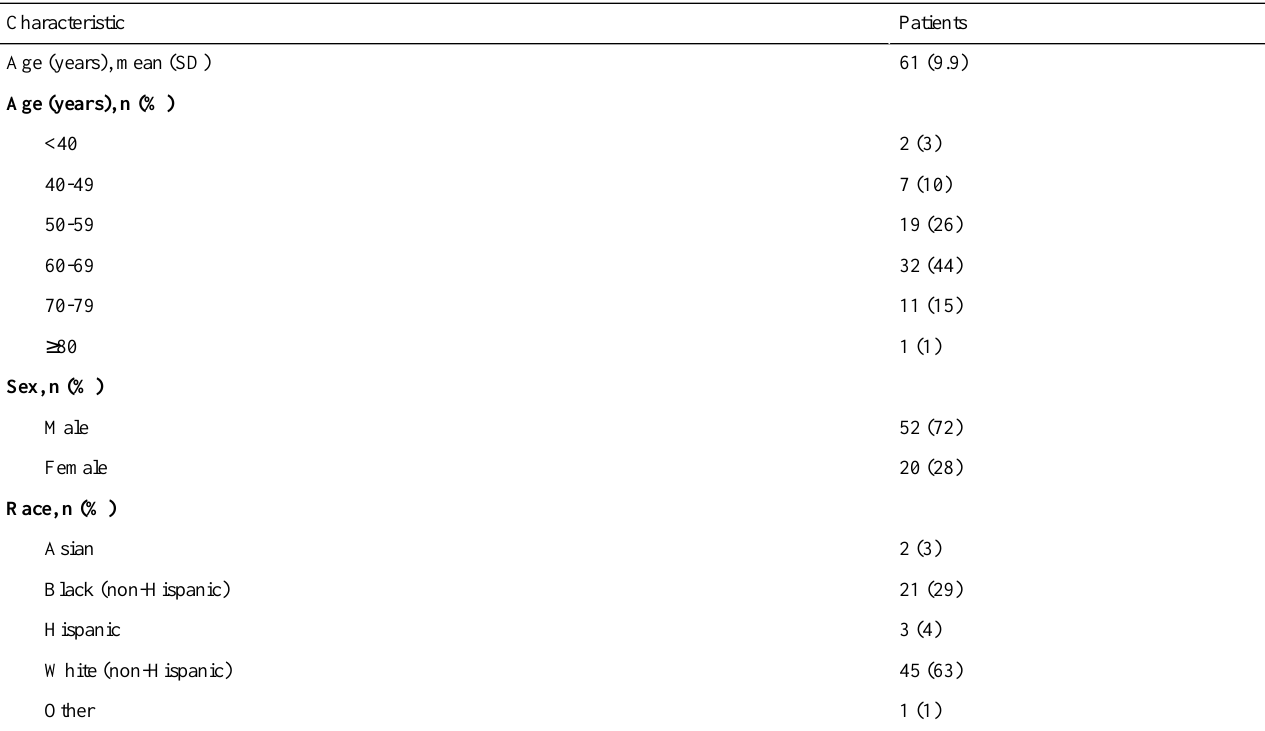
Table 1. Patient demographic data (N=72).